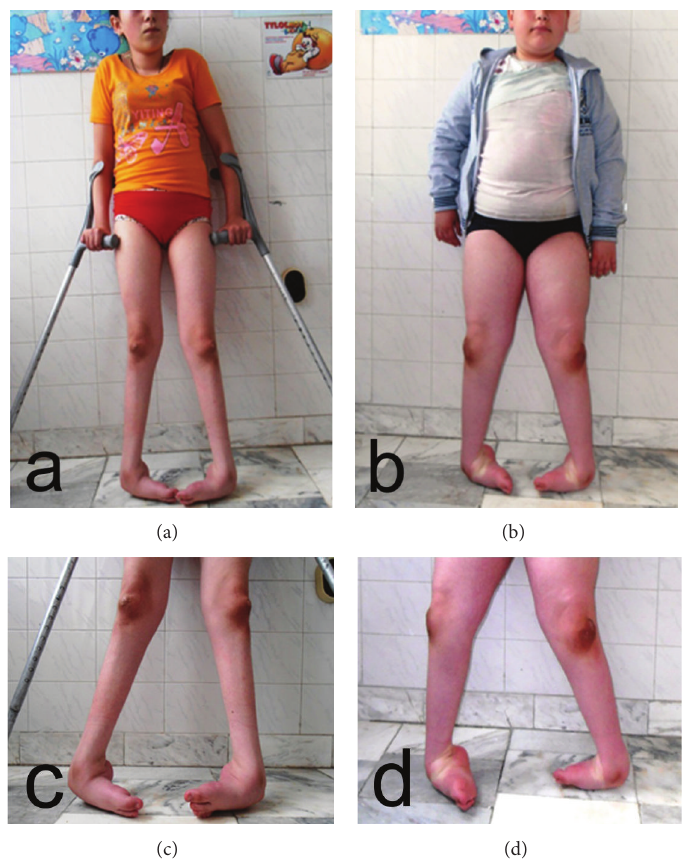
Figure 1: Preoperative photograph of the patients: (a, c) sister and (b, d) brother with hereditary motor and sensory neuropathy type I.